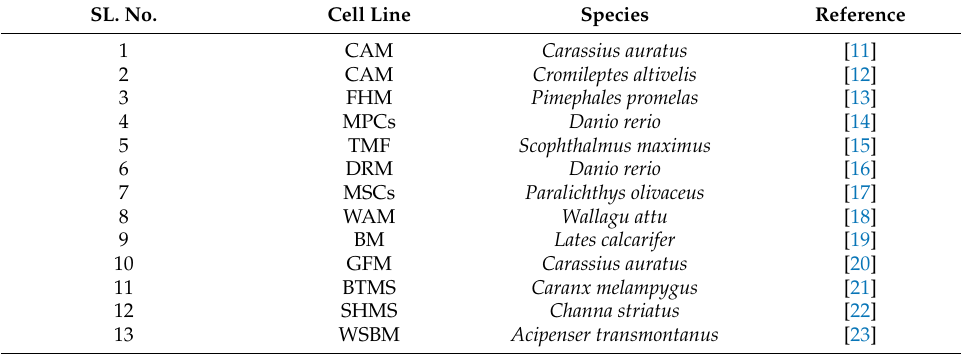
Table 1. Reported Cell Line Developed from Fish Muscle Tissue. SL.